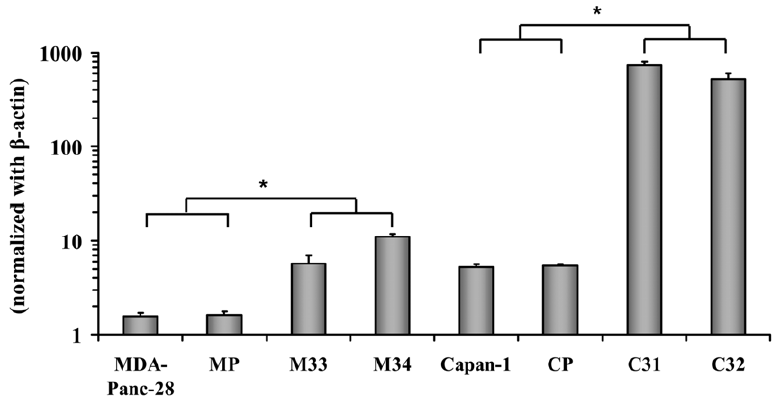
Figure 1. ST3Gal III expression normalized to b -actin of the pancreatic adenocarcionoma cells. MDAPanc-28 parental cells, MP: MDAPanc-28 mock cells, M34 and M33: MDAPanc-28 cells transfected with the ST3Gal III gene. Capan-1 : parental cells, CP: Capan-1 mock cells, C31 and C32: Capan-1 cells transfected with the ST3Gal III gene. Data represents the mean 6 SD of 3 separate experiments, each in six replicates (n=18). * Significantly different ( P , 0.001 ).